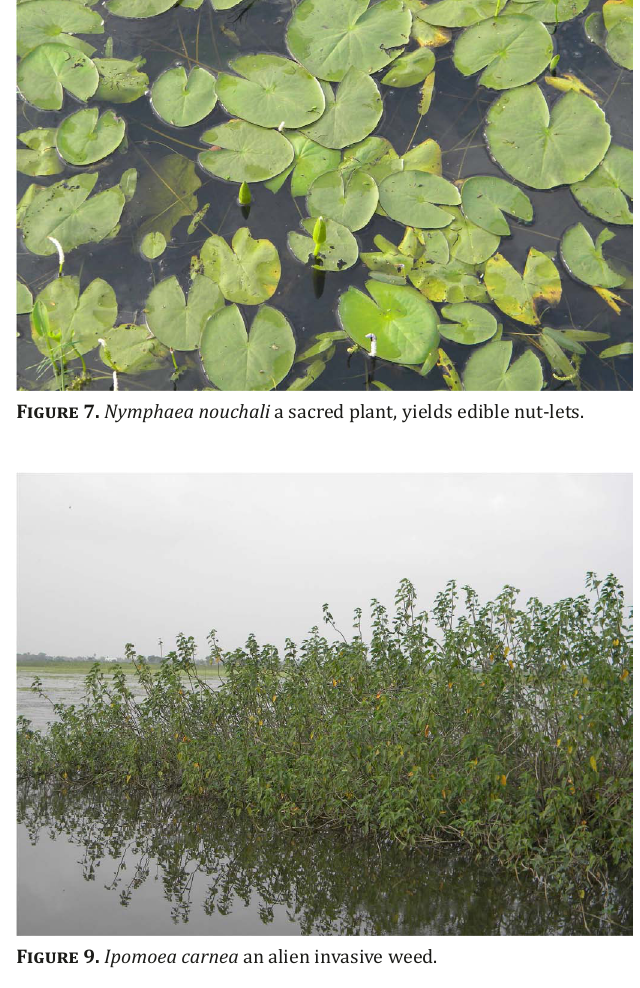
Figure 10. Pistia stratiotes an alien invasive, aggressive weed.